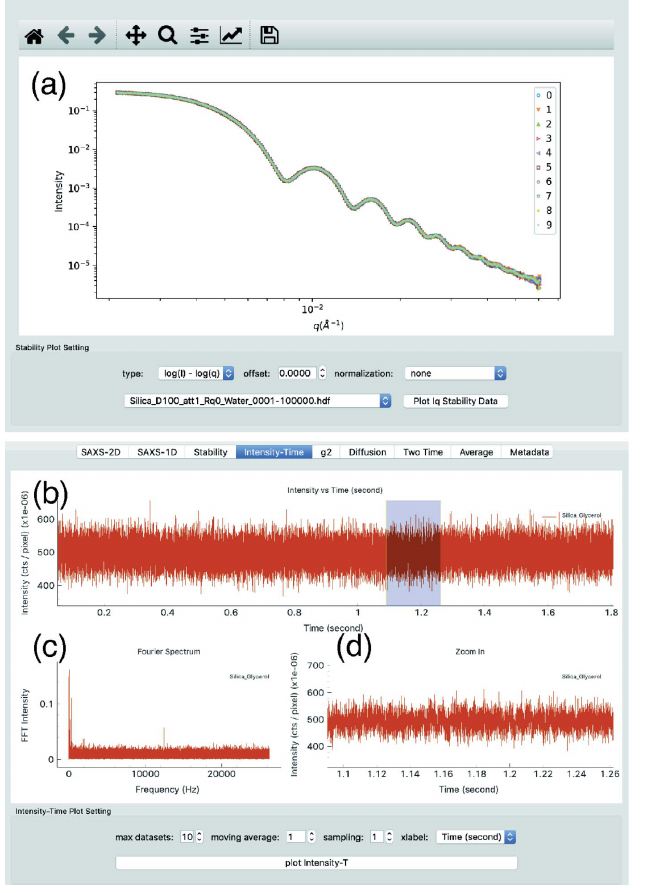
Figure 3 ( a ) Stability plot showing the SAXS 1-D I ( Q ) curves generated from segments of the time series. In this example, the ten curves match indicating that the sample is stable during the measurement. ( b ) The intensity versus time during the XPCS measurement. ( c ) Fourier component analysis of ( b ). ( d ) Zoom-in of the region highlighted by the light blue rectangle in ( b